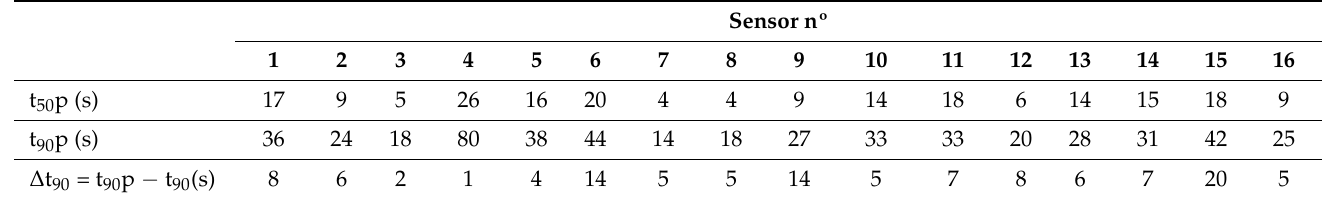
Table 6. Dust effect